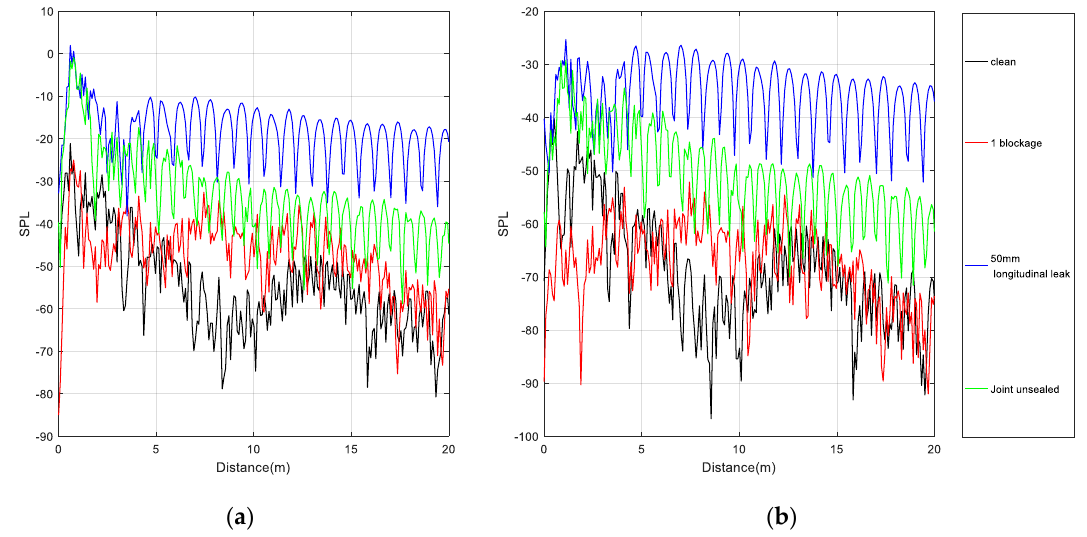
Figure 10. VMD components for four conditions of the siphon. ( a ) BIMF1; ( b ) BIMF2.